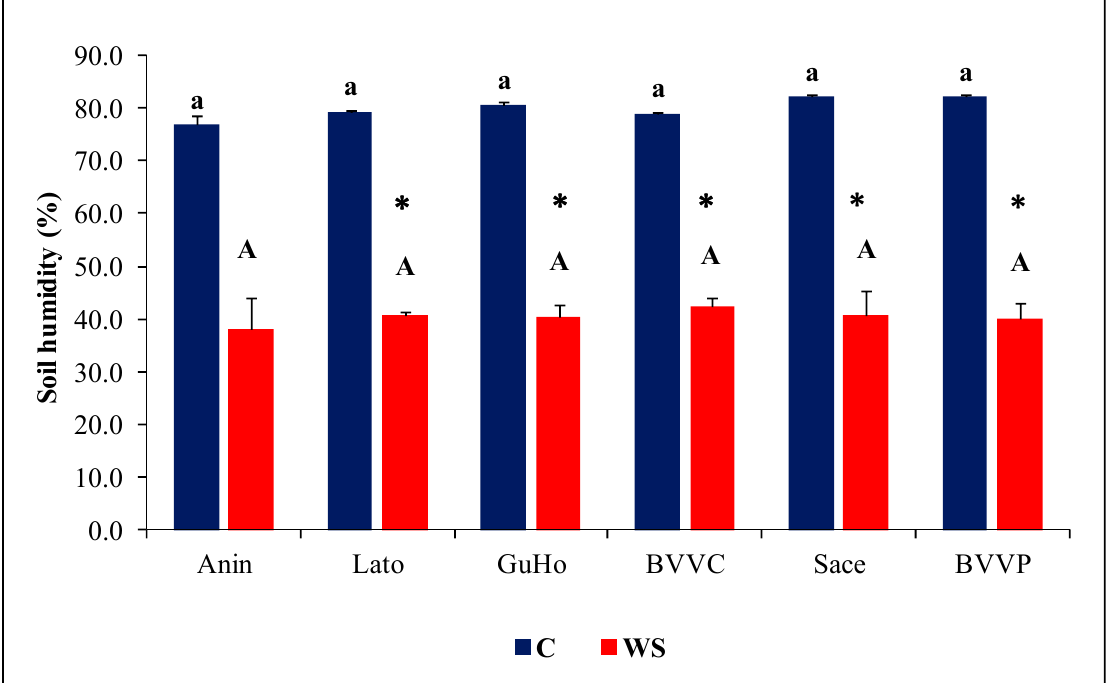
Figure 2. Pot substrate humidity (%) after one month of treatments of six Romanian provenances of L. decidua (Mean ± SE, n = 5). Comparing provenances, different lowercase letters indicate significant differences between control plants, and different uppercase letters indicate significant differences between drought-affected plants, according to Tukey’s test ( α = 0.05). Asterisks indicate a significant difference between treatments within the same provenance, according to the LSD value for the interaction ( p = 0.05).